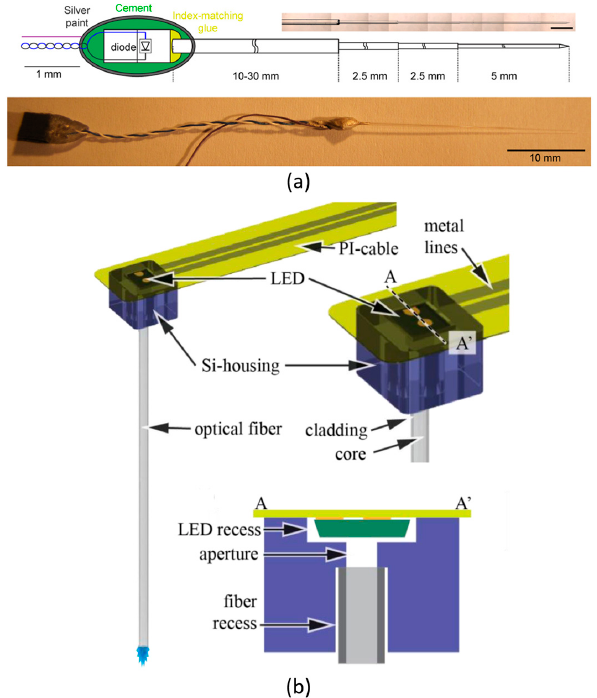
Figure 2. ( a ) Fibre-coupled multi-diode optical array in [38]. A single four-step fibre probe. The total length is 50 mm, and the last shank is 5 mm long with a 12° tip. This figure is reprinted with permission from ref. [38]. ( b ) Cartoon image of the fibre-coupled µLED optical probe [39]. This system mainly consists of a 270 × 220 × 50 µm 3 LED chip, a flexible PI cable, a 550 × 500 × 380 µm 3 Si housing, and a 5 mm-long optical fibre with 125 µm diameter. This figure is reprinted with permission from ref. [39].